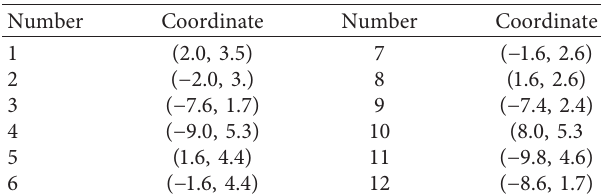
Table 3: Position of